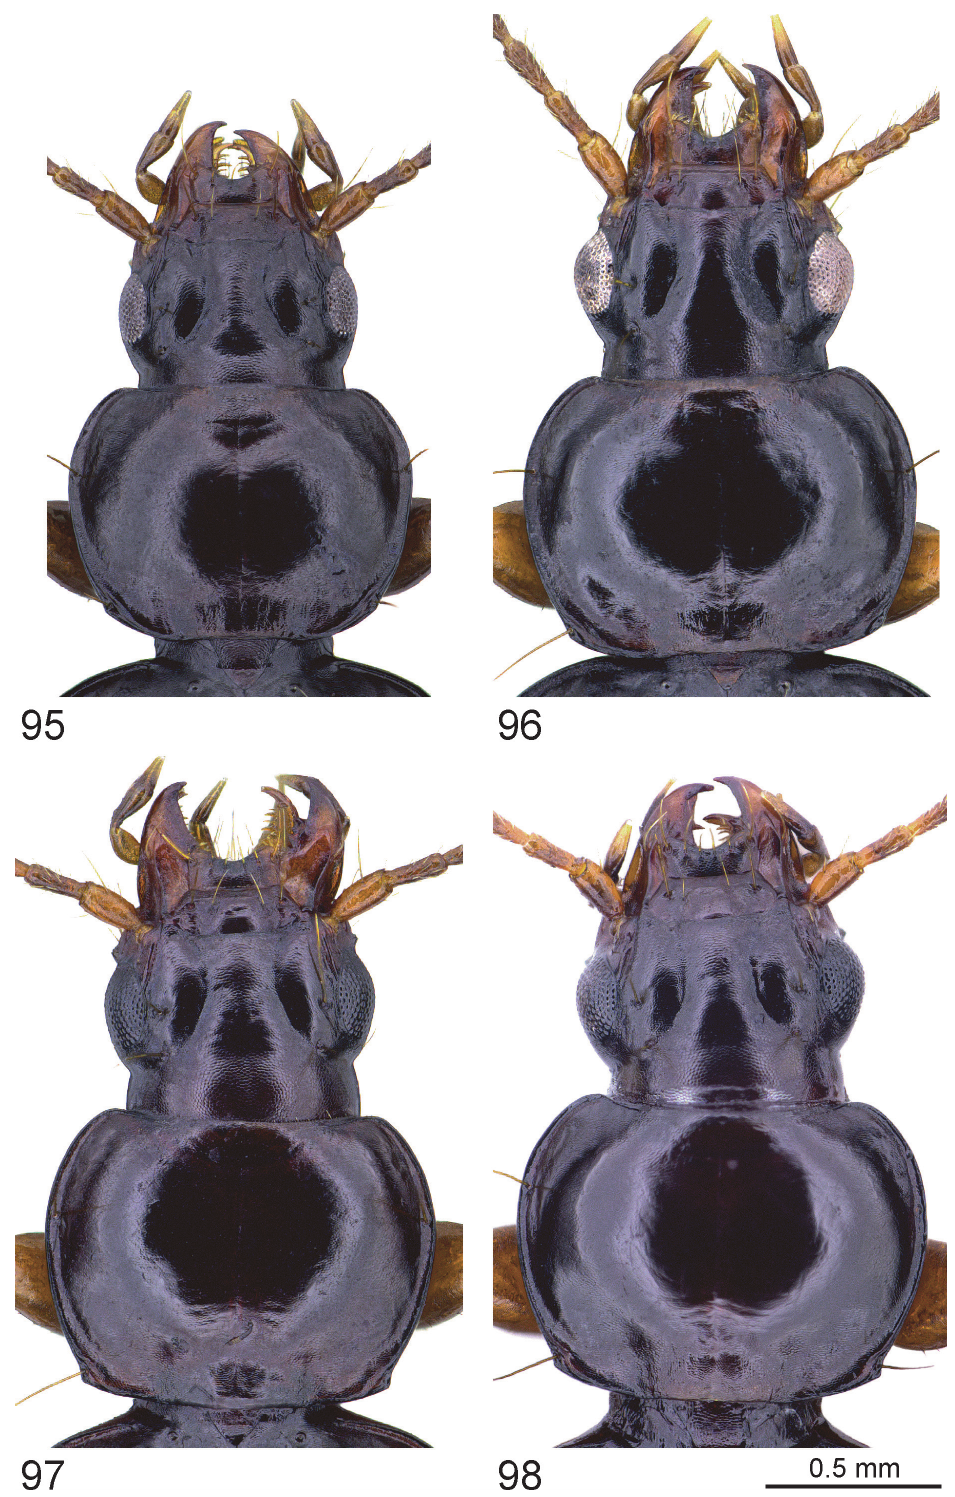
Figs 95–98. Trechus spp., head, pronotum. 95 . T. fisehai sp. nov., paratype, ♂. 96 . T. angavoensis sp. nov., holotype. 97 . T. batuensis Magrini & Sciaky, 2006, ♂ from Sanetti Plateau near Tulo Dimptu. 98 . T. batuensis , ♂ from Tegona